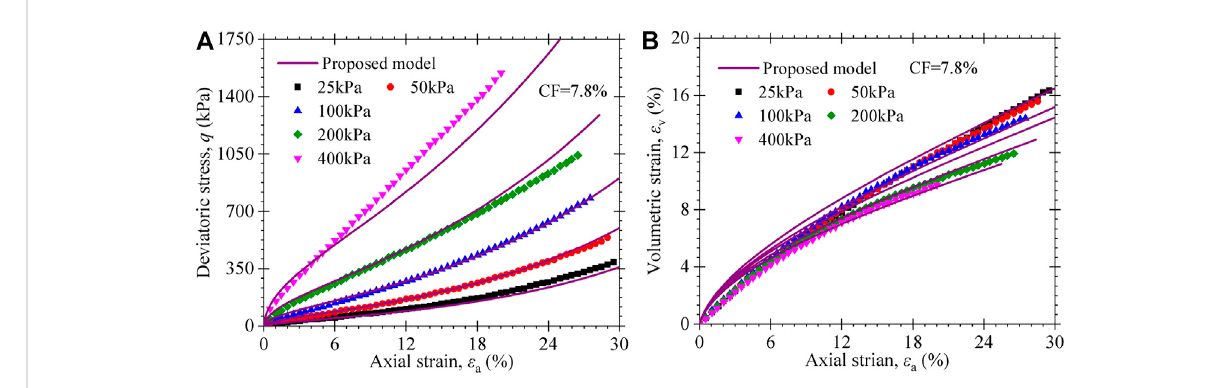
ExperimentalandpredictedtriaxialcompressiontestresultsofMSWspecimenswith7.8% fi brouscontentfromRamaiahandRamana(2017): (A) stress – strain curves; (B) volumetric strain vs. axial strain curves.